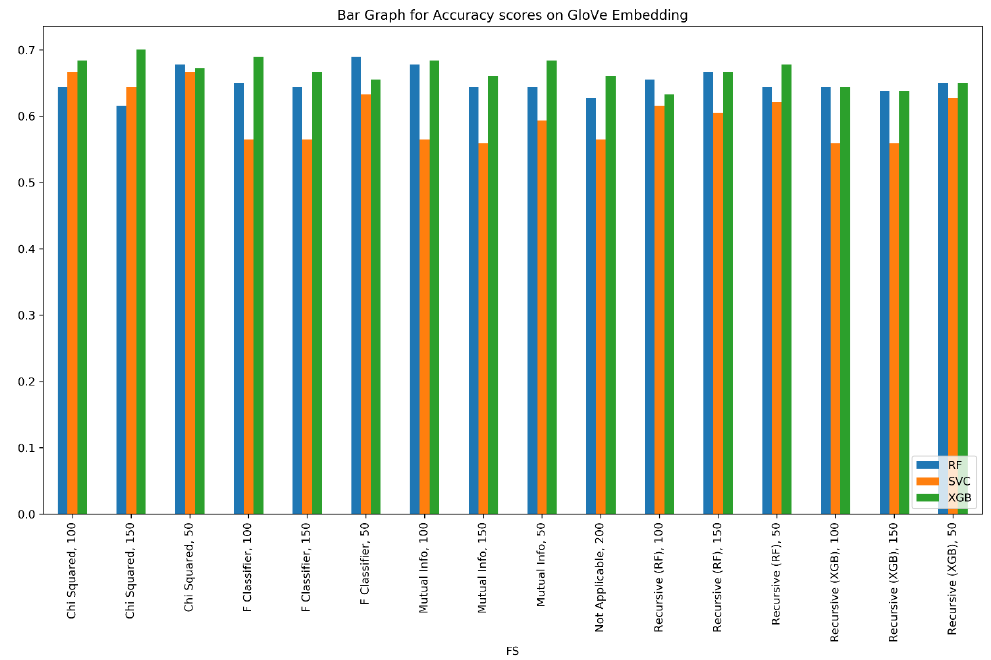
Figure 7. Bar graph showing the F 1 scores on GloVe embedding, for all combinations of feature selection methods and number of features.